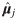
Gene expression variance can be partially explained by directed genome annotations.The BAGEA model was fitted on genes in the training set (all genes on chromosomes 1 through 15) using monocyte eQTL data on genes with a top nominal p-value below 10−10, and with ExPecto-derived directed annotations. ExPecto includes 2002 annotations in total, of which one of two subsets were used: 253 annotations derived from histone and DHS assays in a blood related cell types (Blood), or, alternatively, 690 annotations derived from TF ChIP-Seq (TF). For each gene j in the test set (all genes on chromosomes 16 through 22 with a top nominal p-value below 10−10), we calculated the directed predictor of expression μ^j. As a measure of a predictor’s size, we use its squared magnitude Sj=μ^jTμ^j. To evaluate the predictor’s performance, we calculated MSEjdir, the mean squared error (MSE) when predicting gene expression yj from μ^j. To estimate what the smallest attainable MSEjdir would be, we estimated σgcis2, the additive genetic variance in cis via Haseman-Elston regression per gene. (A) The relationship between the MSE of the predictor and its squared magnitude. We sorted results by predictor Size Sj and averaged MSEjdir within a sliding window containing 25% of genes and step size of 5% of data. Averaged Directed Predictor Size
S¯: The mean value of Sj per window on the horizontal axis; Averaged Directed MSE (MSEdir¯): The averaged MSEjdir of genes falling into the window on the vertical axis. The 95% confidence interval for each window was derived by bootstrapping. Most variance is explained by genes in the top quartile when ranked by Sj. (B) The relationship between MSEjdir and σgcis2 for genes in the top quartile when ranked by Sj. Genetic Variance (σgcis2): The estimated additive genetic variance in cis on the horizontal axis. Directed MSE (MSEjdir) on the vertical axis. 95% confidence intervals for the mean of both the MSEdir and σgcis2 are represented as the corners of the red diamond (i.e. the confidence interval for the average MSEdir is given by the upper and lower corner, whereas the confidence interval for the average σgcis2 is given by the right and left corner respectively). A linear regression is plotted as the blue line, with 95% confidence interval shown in grey.